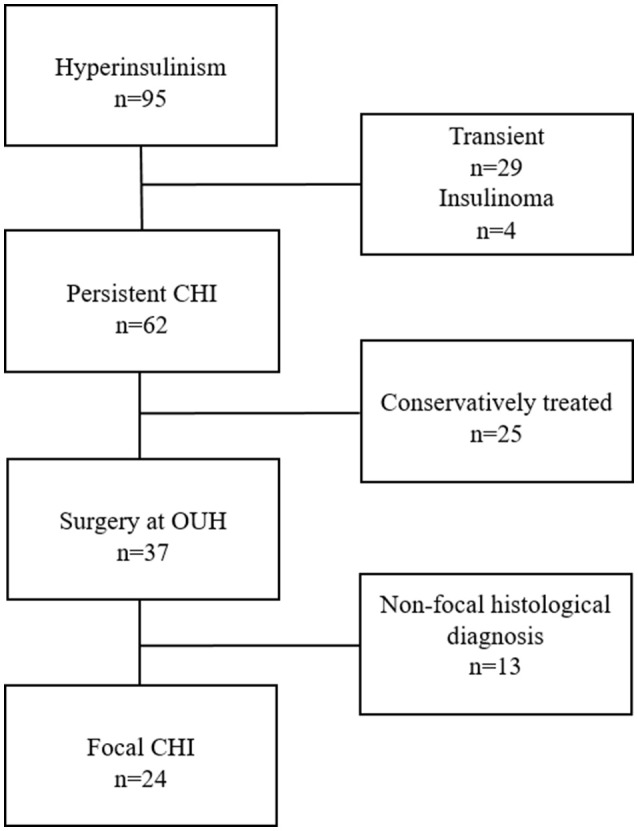
Patient inclusion flow chart.